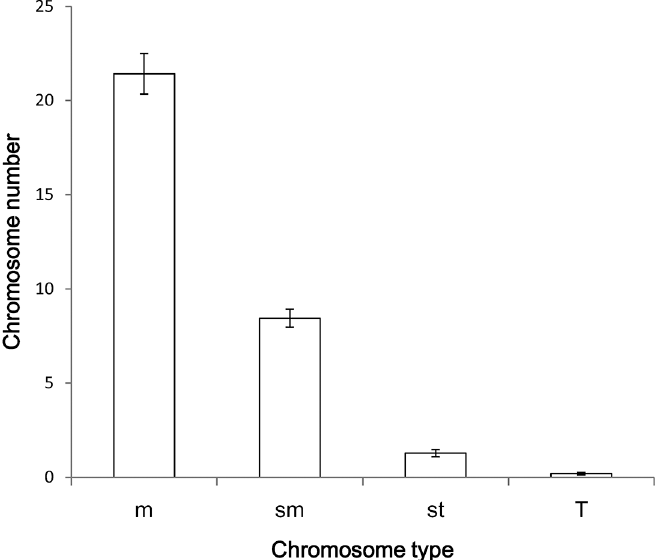
Fig 1. Frequency distribution of the number means of different chromosome types for the 191 woody broad-leaved species, which were averaged within the same type of chromosomes across species. Wherein (B), m, sm, st and T were m-, sm-, st- and T-chromosome, respectively. ± bars indicated standard